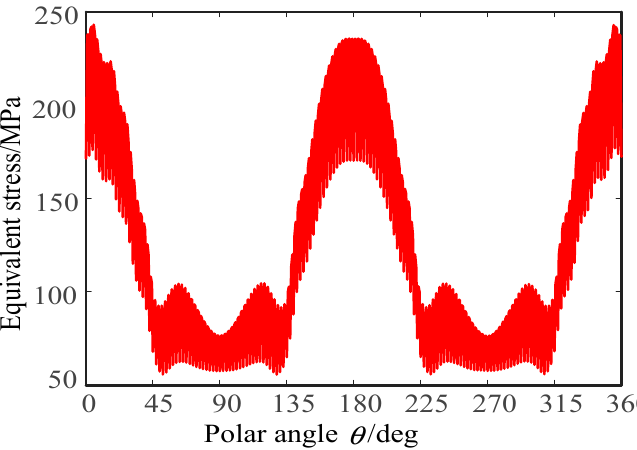
Figure 9. Equivalent stress distribution curve of the section in the ring gear.